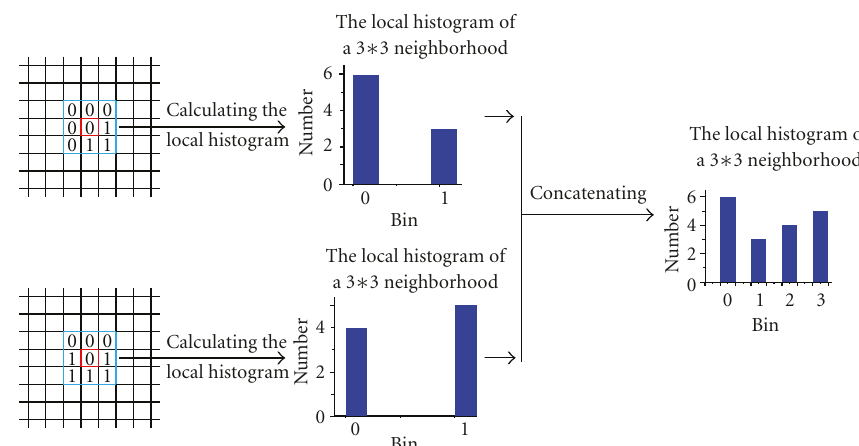
Figure 2: One simple example of constructing local histogram of figure/ground segmentations to form a final representation for a pixel using a 3 ∗ 3